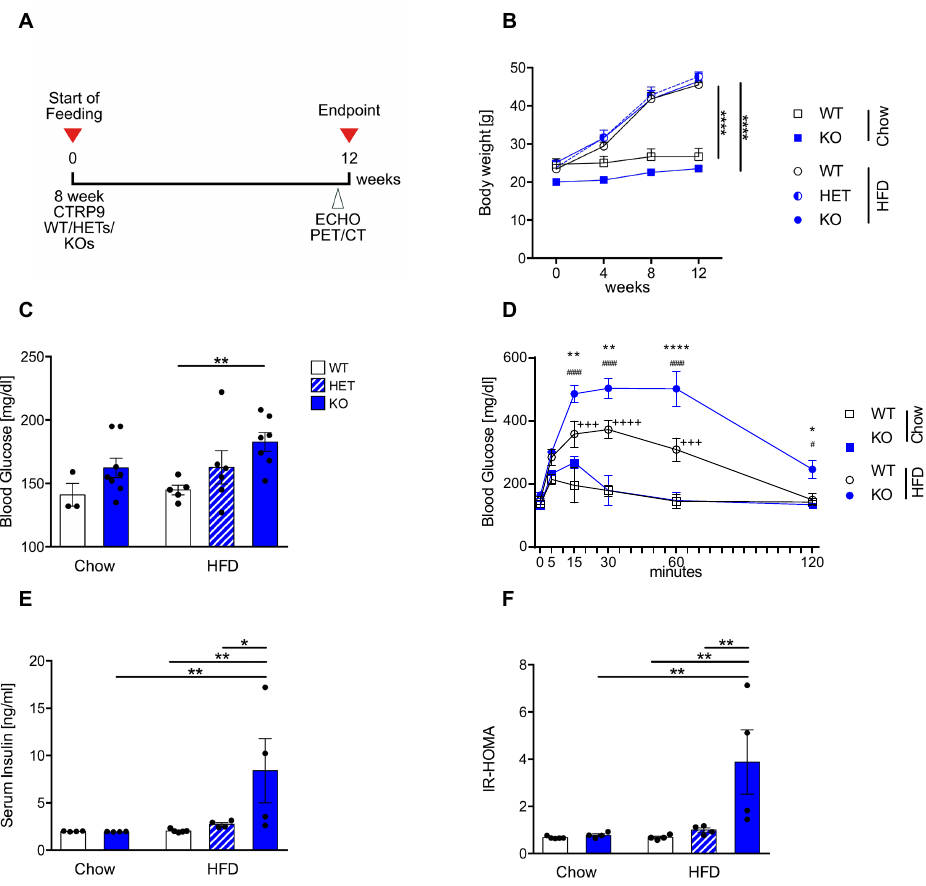
Figure 1. CTRP9 knock-out leads to peripheral insulin resistance after high fat diet (HFD) feeding. (A) Scheme showing the experimental timeline. (B) Body weight measured 4, 8 and 12 weeks after start of diet. WT: wild-type mice; KO homozygous and HET heterozygous CTRP9 knock-out mice. (C) Fasted serum glucose levels. (D) Glucose tolerance test. */**/**** indicates significance between WT HFD vs. KO HFD. +++/++++ indicates significance between WT HFD vs. WT Chow. #/#### indicates significance between KO HFD vs. KO Chow. (E) Serum insulin levels. (F) HOMA-Index of insulin resistance. Data are shown as mean ± standard error of the mean (SEM). *p<0.05, **p<0.01, ****p<0.0001; #p<0.05, ####p<0.0001; +++p<0.001 ++++p<0.0001